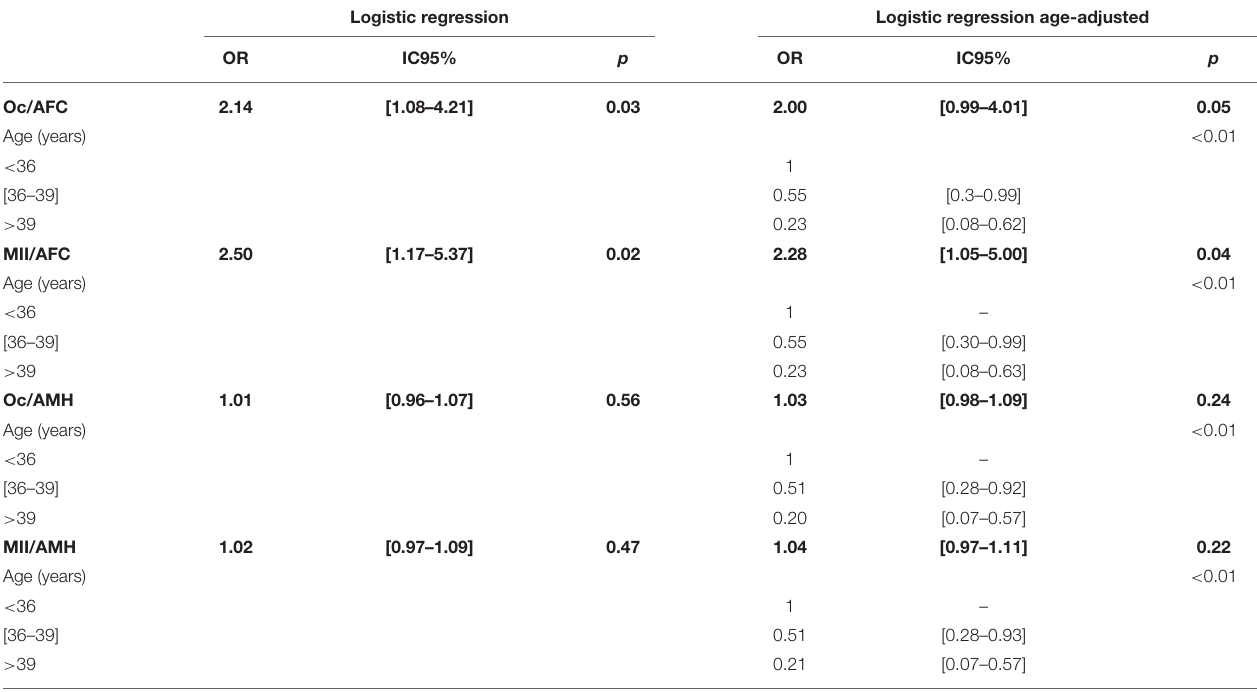
TABLE 2 | Odds ratios of oocyte yield indices after first embryo transfer according to age groups Naissance. Logistic regression Logistic regression age-adjusted OR IC95%